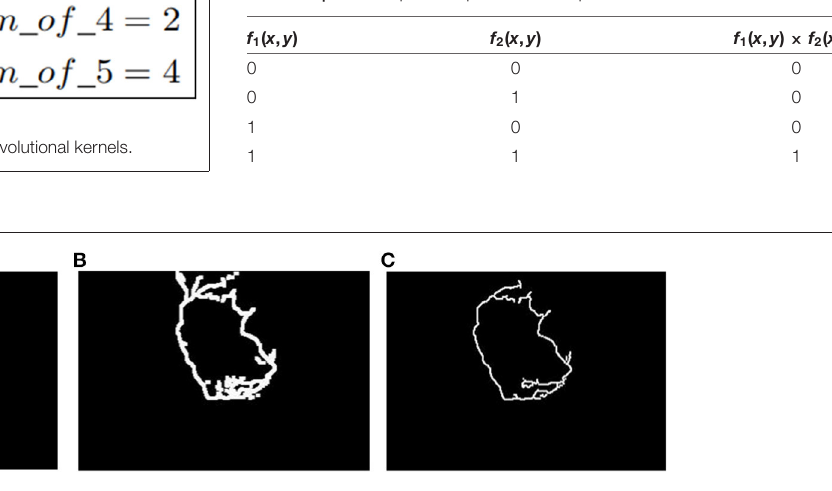
TABLE 1 | The multiplication process of the pixel values.